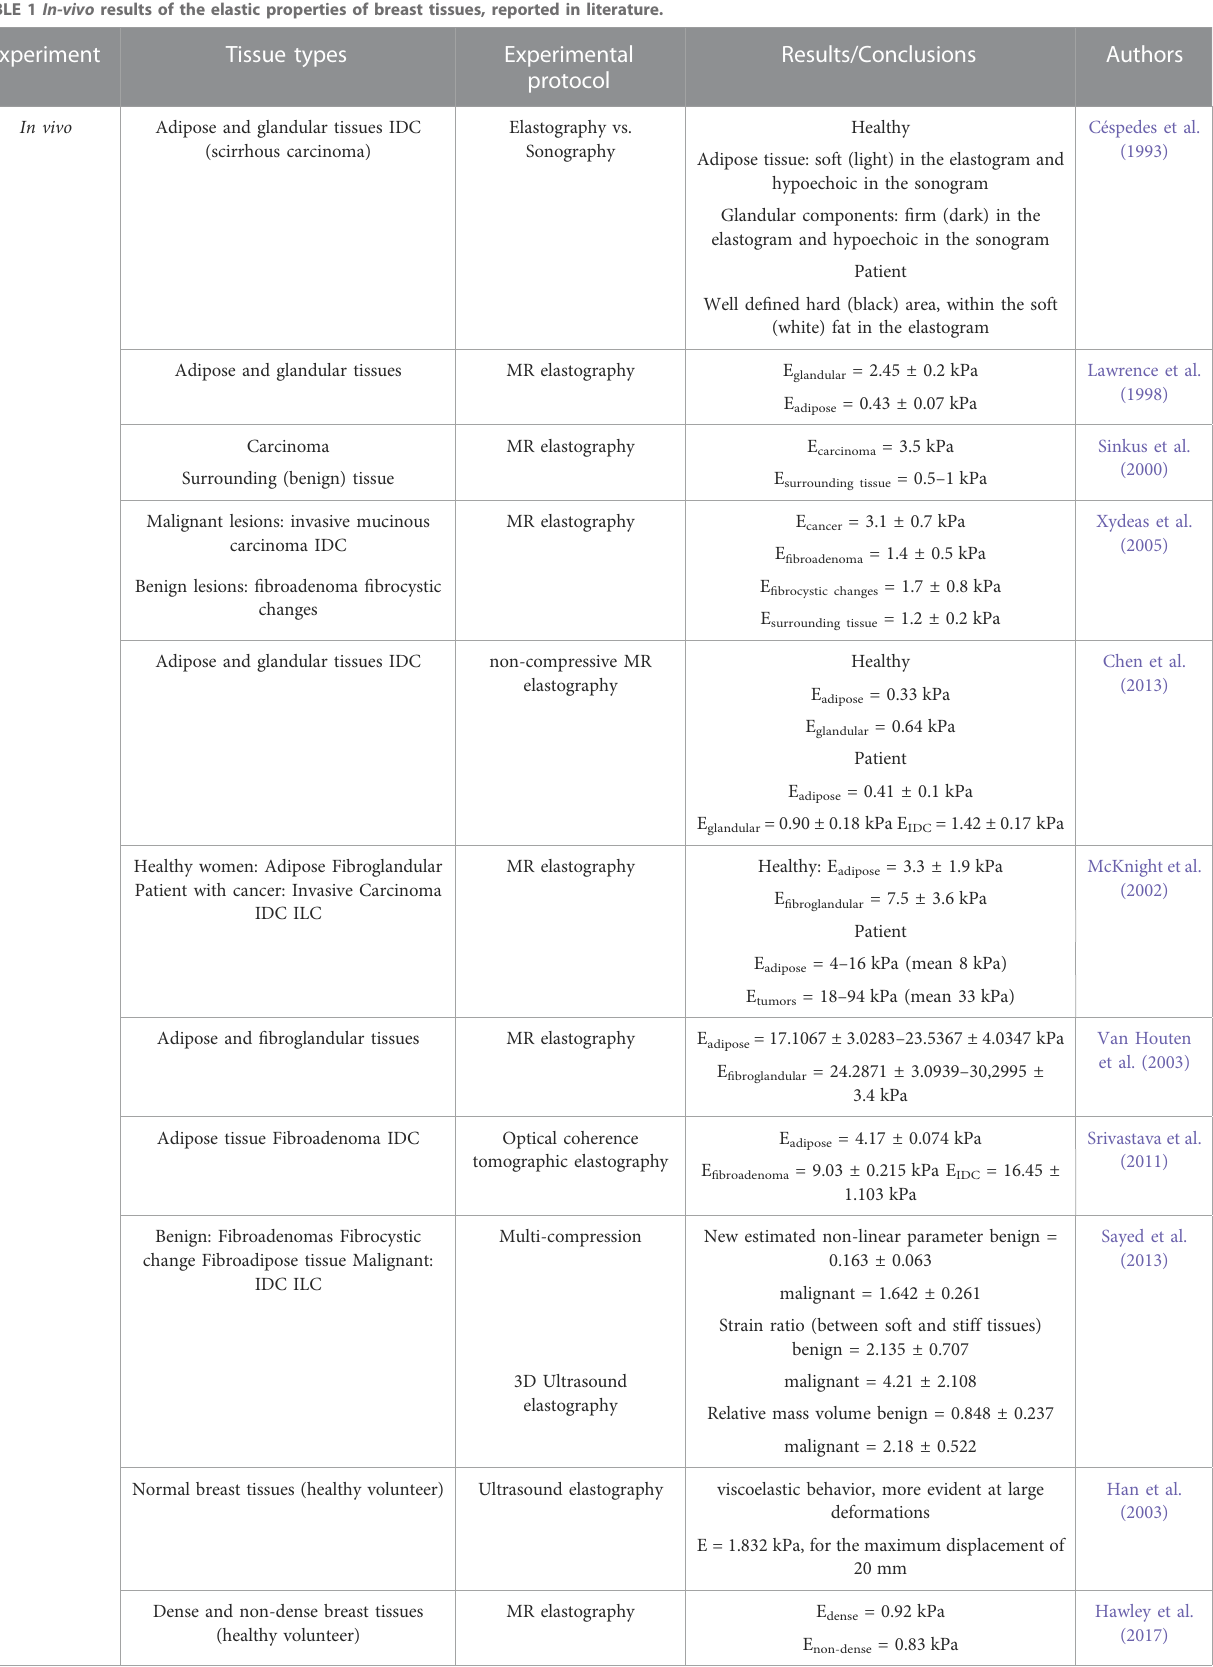
TABLE 1 In-vivo results of the elastic properties of breast tissues, reported in